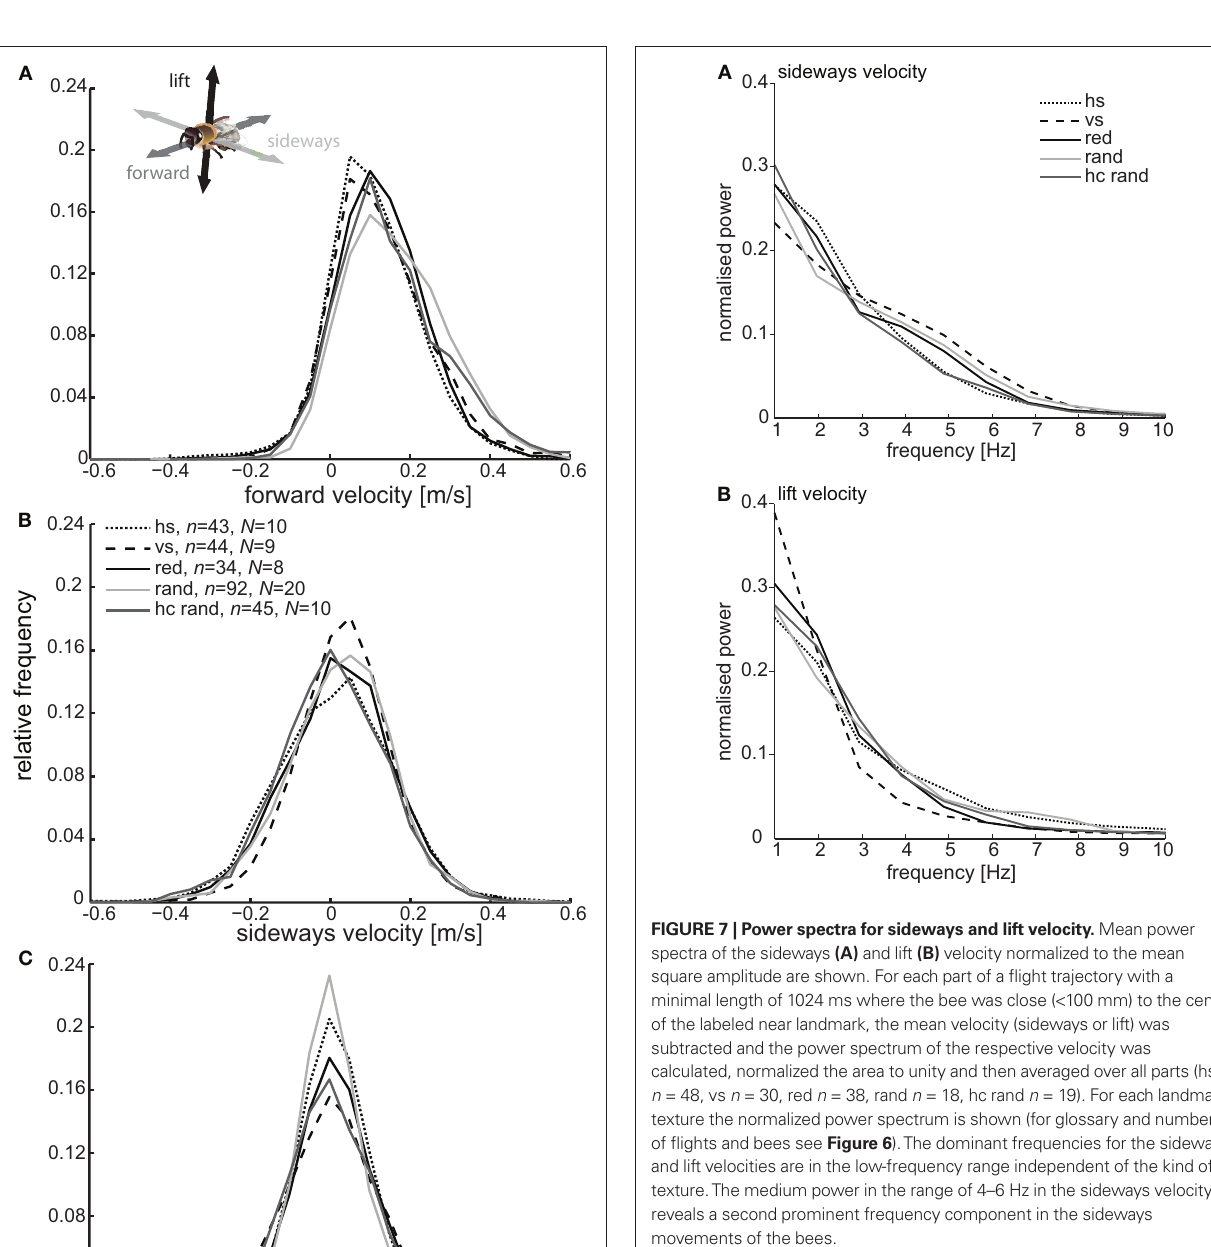
dot texture, which provided contrast cues against the background, was used as a label, the bees’ flight behavior became similar to that under the red texture condition (compare Figures 6A–C ). However, some small differences in the sideways and lift velocity remain, e.g., due to textural cues that provide horizontal and vertical contours on the landmark.